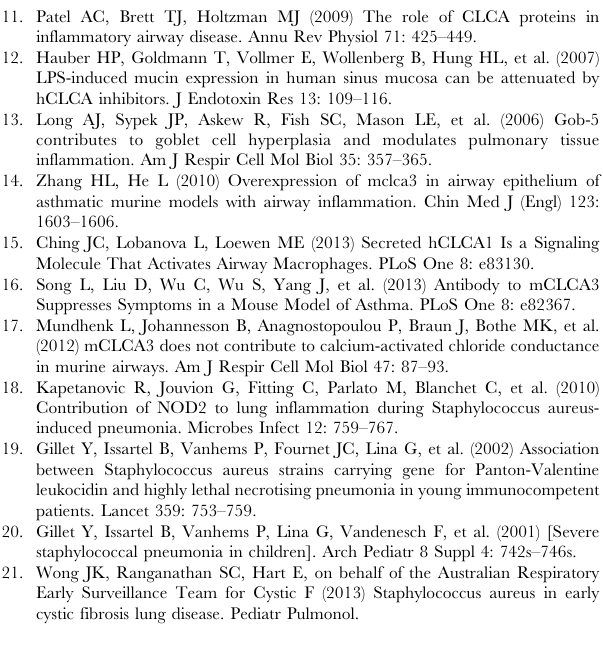
Table S1 Quantitative Real Time RT-PCR: Sequences and